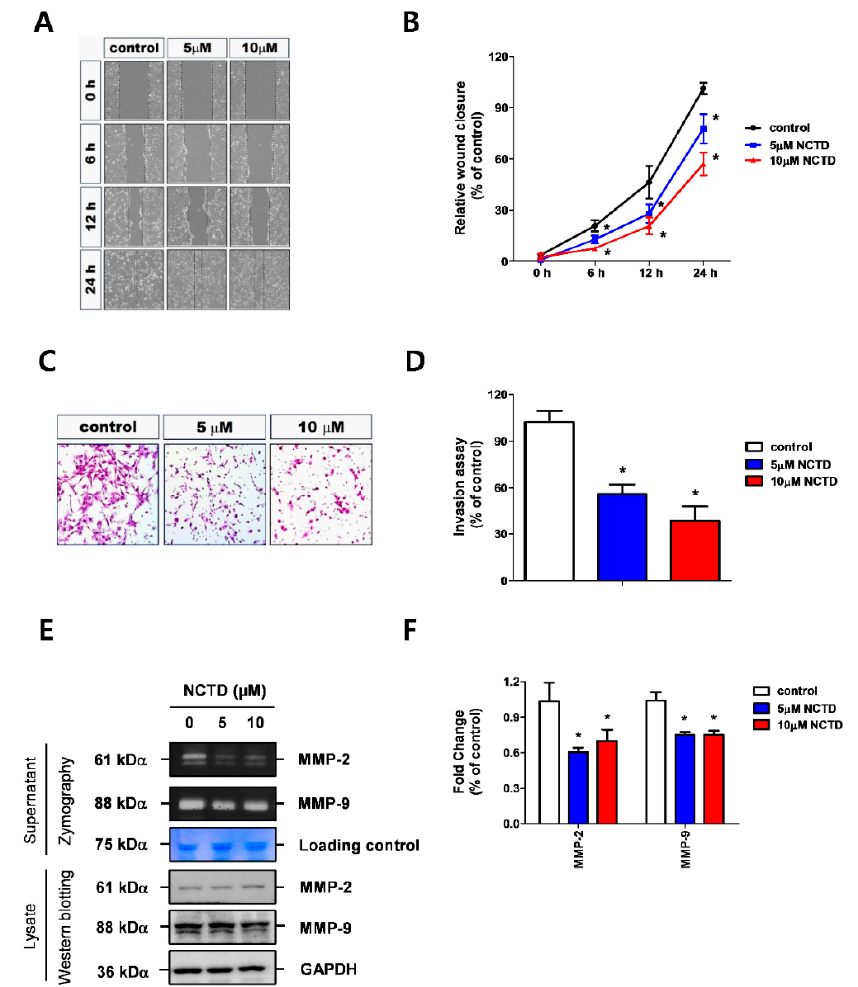
Figure 2. NCTD inhibits the migration and invasion of YD-15 cells. ( A , B ) Wound-healing assay of cell migration after treatment of NCTD (5 and 10 µ M) in YD-15 cells for 24 h. The dotted lines delineate clear zones at various time-points. ( C , D ) Transwell assay for cell invasive potential after treatment with NCTD in YD-15 cells. ( E , F ) Effects of NCTD on MMP activity using gelatin zymography and western blotting. Graphs show the mean ± SD of triplicate experiments and significance compared with the vehicle control (* p < 0.05).